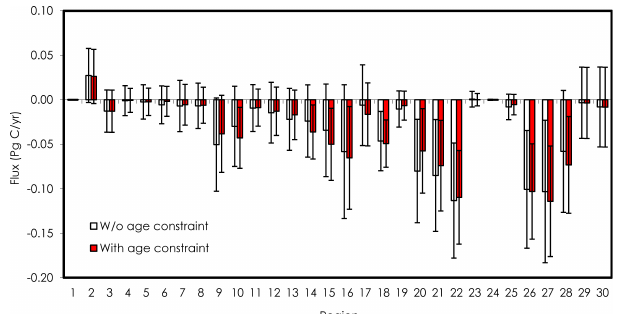
Fig. 3. Inverted CO 2 fluxes and uncertainties for 30 North America regions when the forest stand age information is not considered as a constraint (empty square) and when it is considered as a constraint (red solid